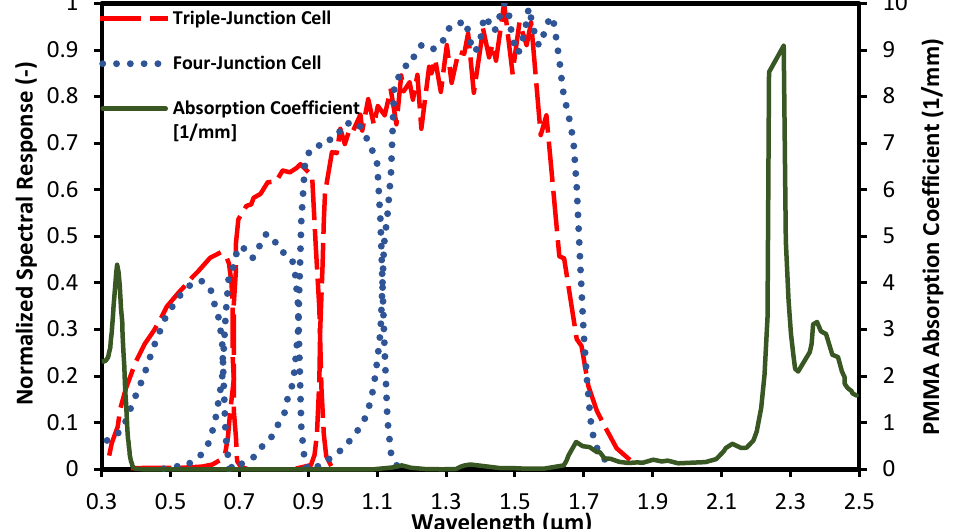
Figure 1. Normalized spectral responses of both TJSC [16] and FJSC [17], as well as the absorption coefficient of the PMMA.